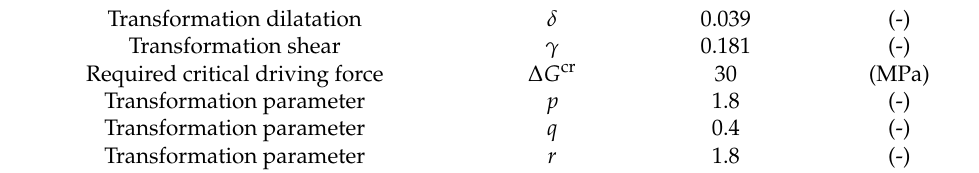
Table 4. Data for transformation of retained austenite in TRIP-aided DP steel.